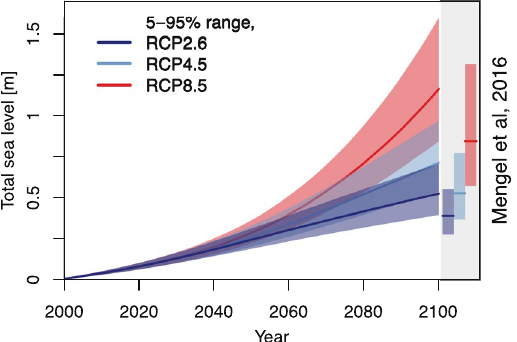
Figure 2. Future probabilistic global sea-level projections for the 21 st century under RCP2.6 (dark blue), RCP4.5 (light blue) and RCP8.5 (red) forcing scenarios 30 , compared to the projections for 2100 by Mengel et al . 12 (vertical side bars).